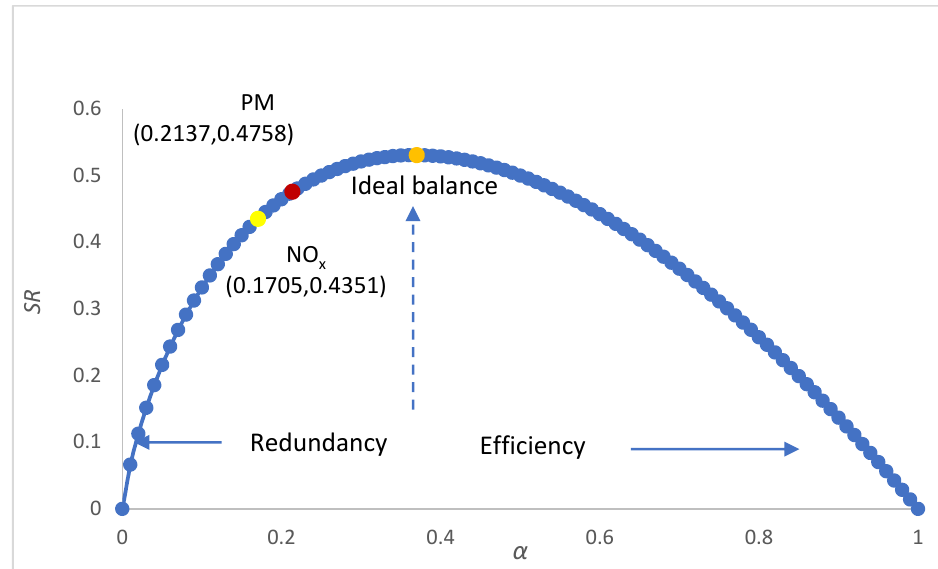
Figure 8. Robustness of air pollutant emission systems.